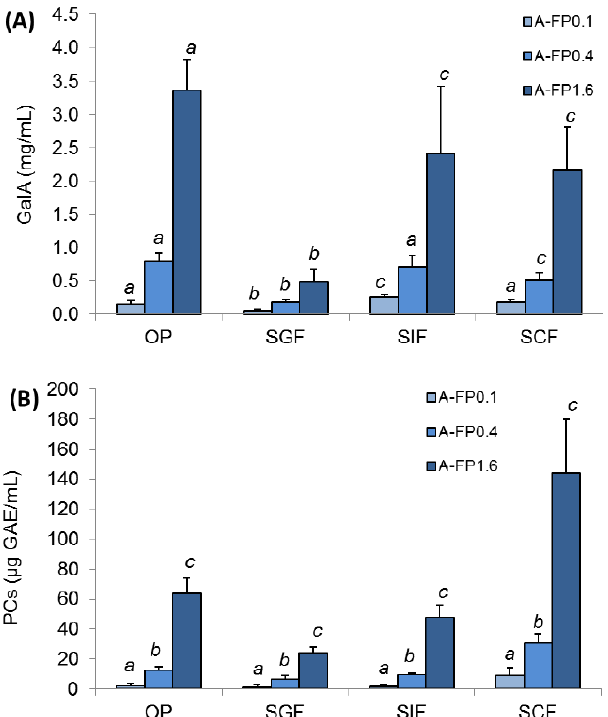
Figure 5. The amount of galacturonic acid (GalA) residues ( A ) and total phenolic compounds (PCs) ( B ) released from A-FP gels during successive oral in vivo (OP) and gastrointestinal in vitro phases of digestion. SGF, SIF, and SCF—simulated gastric, intestinal, and colonic fluid, respectively. Mean ± SD. Different letters among means for the same gel in different phases of digestion— p < 0.05 ( n = 6).